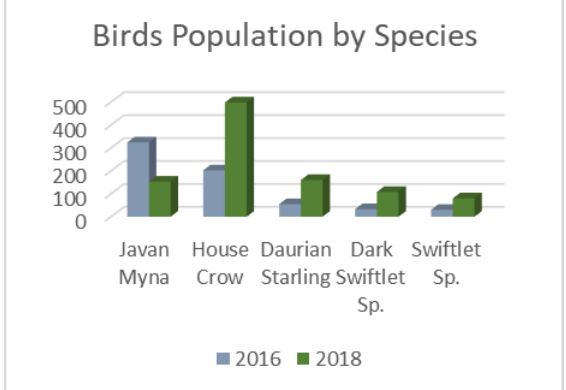
Figure 1 Number of birds spotted in year 2016 and 2018